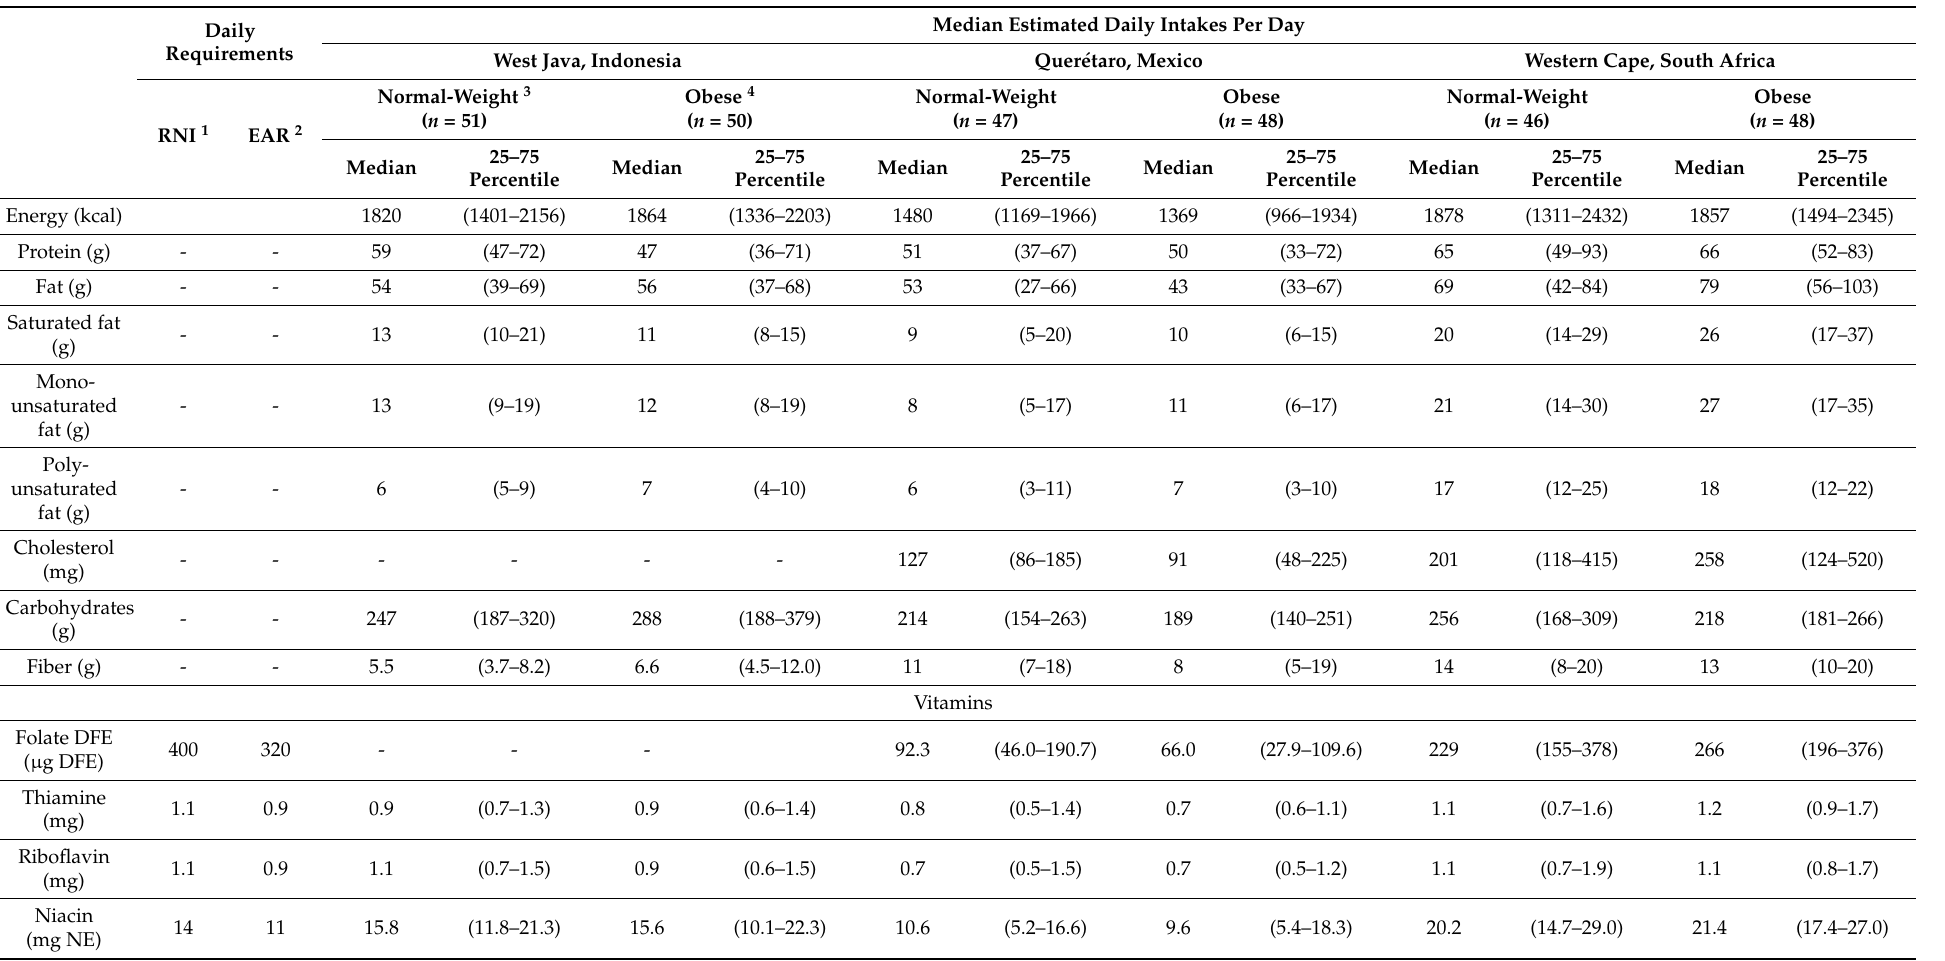
Table 2. Median estimated daily intakes based on a single 24 h dietary recall by survey area for normal-weight vs. obese